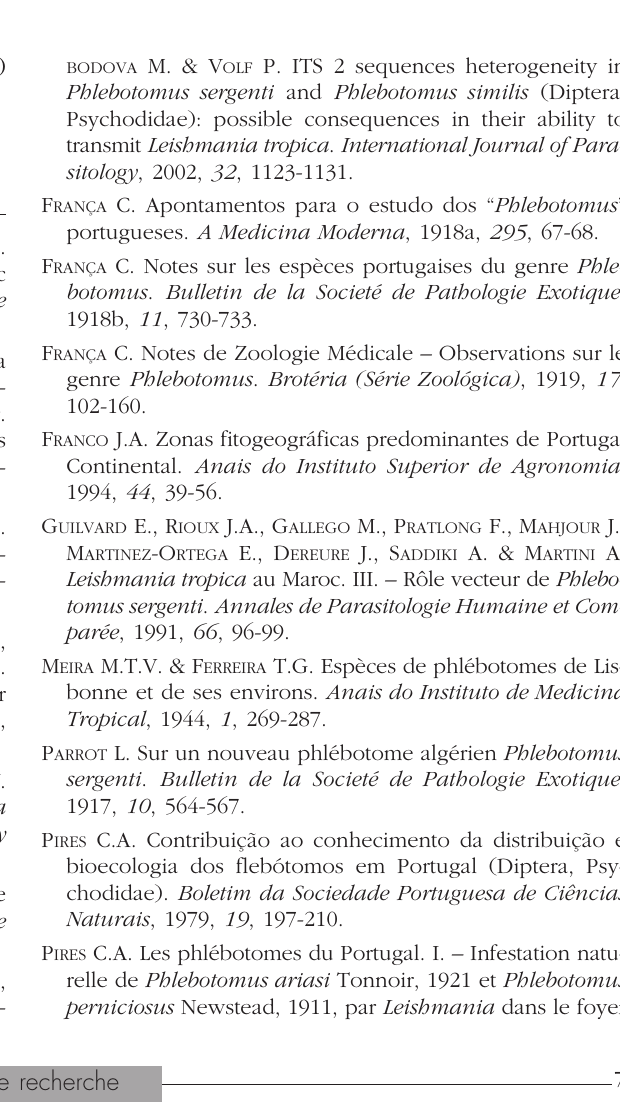
Table I. – Distribution of P. sergenti Parrot, 1917 in